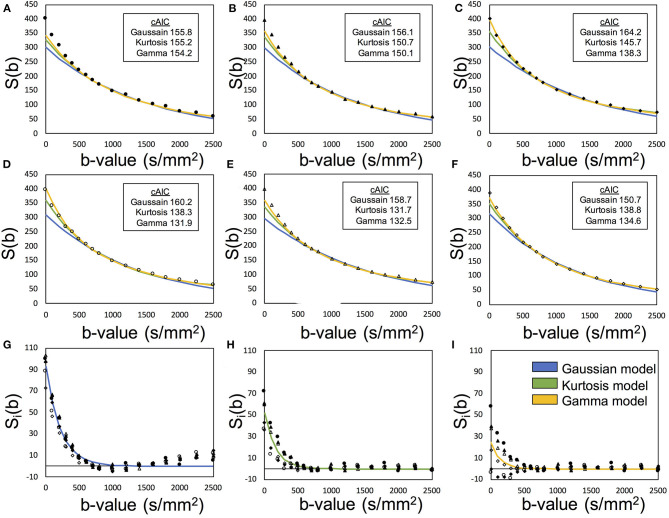
Demonstration of the two-step asymptotic fitting of a gray matter voxel. The blue, green, and yellow curves indicated the fittings by Gaussian model, Kurtosis model, and Gamma model, respectively. (A–F) showed the diffusion fitting along six MPG directions. (G–I) showed the residual signals by removing diffusion components with Gaussian model fitting, Kurtosis model fitting, and Gamma model fitting. The mark styles of solid circle, solid triangle, solid square, hollow circle, hollow triangle, and hollow square indicated the data from the MPG directions of [1,1,0], [0,1,1], [1,0,1], [1,-1,0], [0,1,-1], and [−1,0,1], respectively.